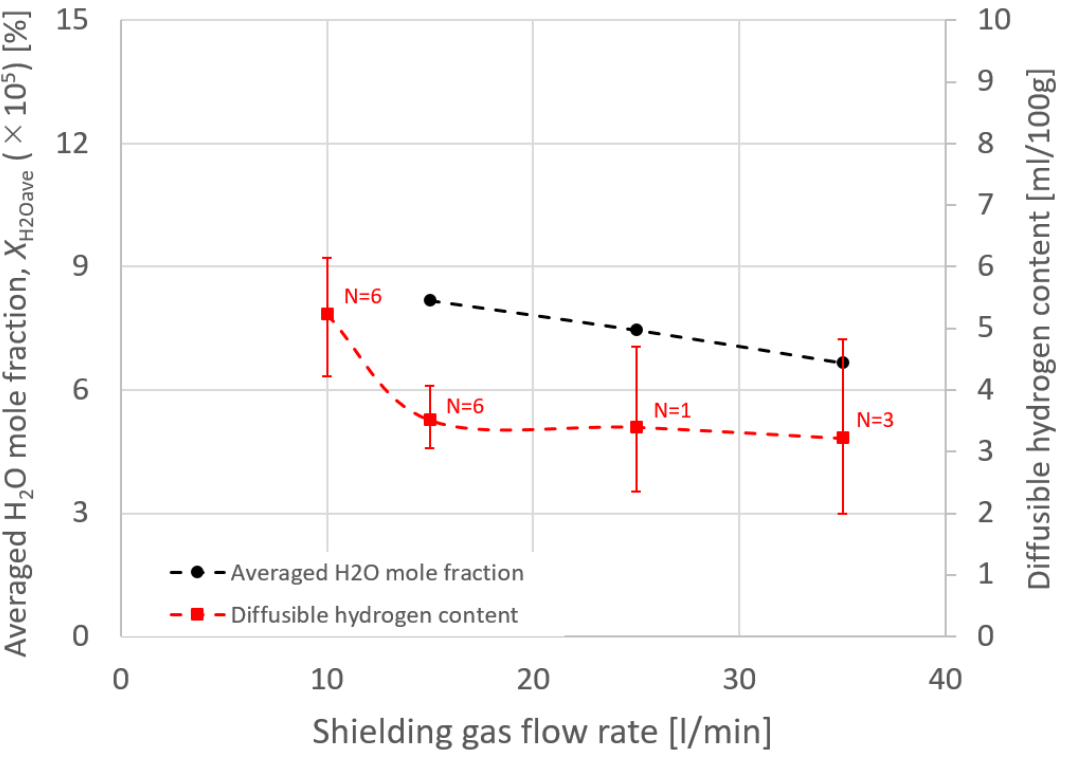
Figure 9. The measured diffusible hydrogen content and the averaged H 2 O mole fraction as a function of the shielding gas flow rate.